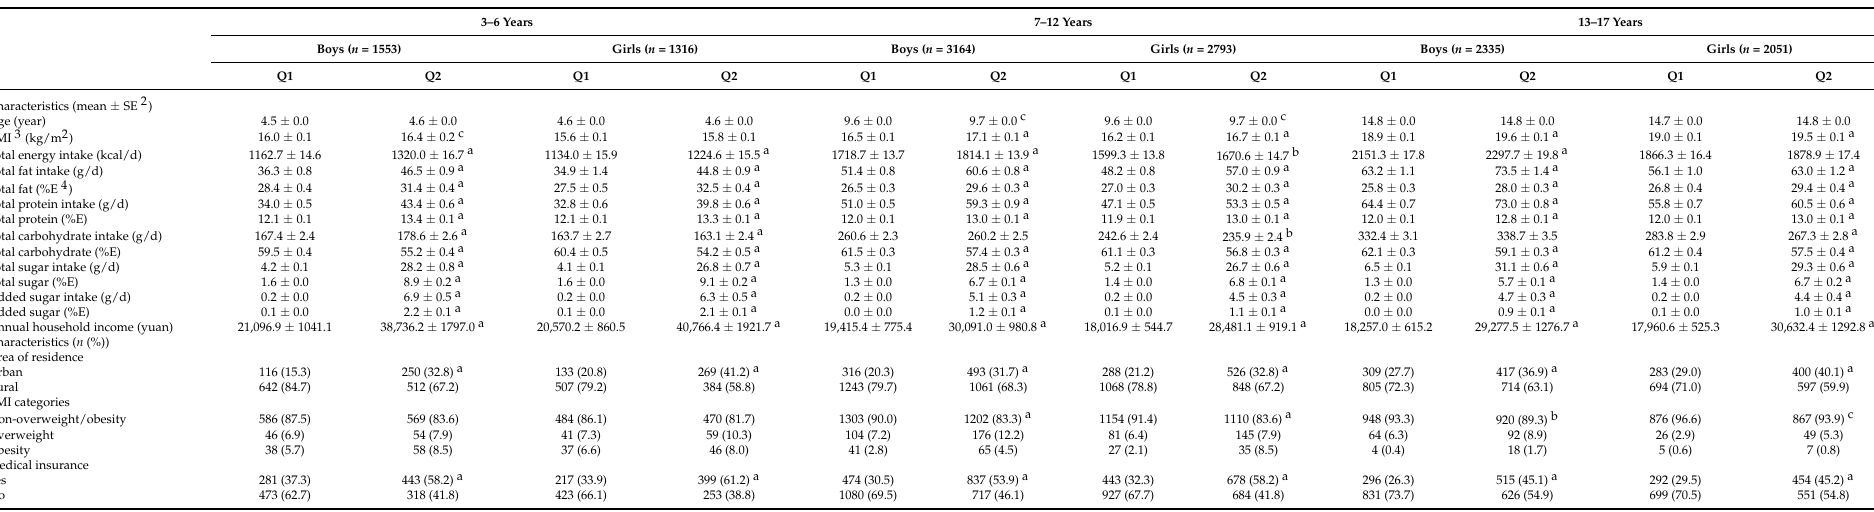
Table 2. Comparisons of basic demographics and characteristics of Chinese children and adolescents with different total sugar intake, CHNS 1